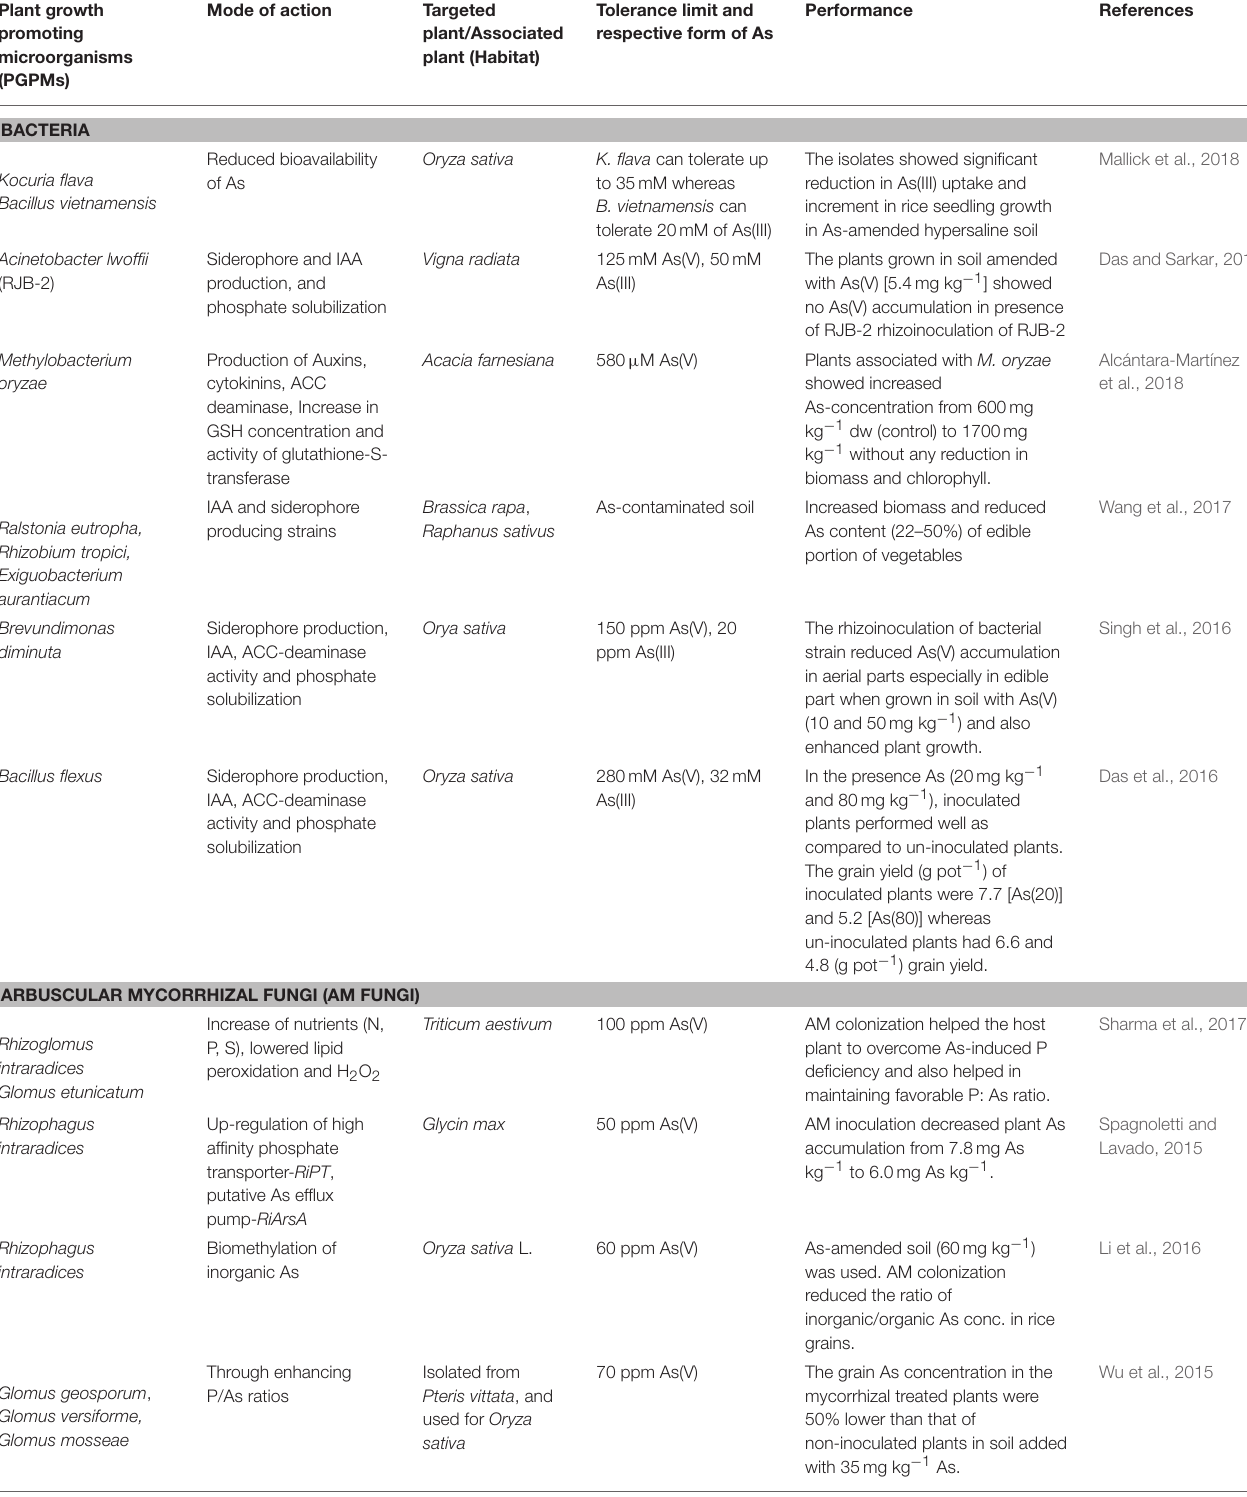
TABLE 1 | A summary of recent reports on the utilization of PGPMs for the amelioration of As stress and for regulating As accumulation in